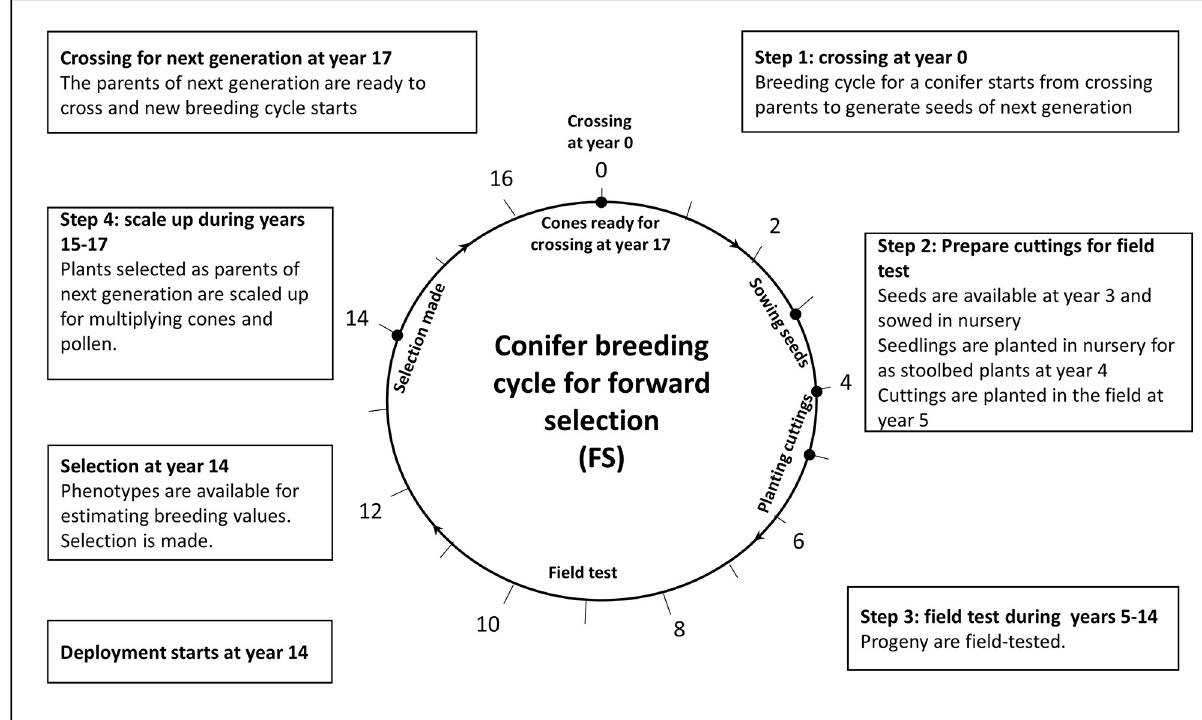
Fig 1. Example of conifer breeding cycle for conventional forward selection with a generation interval of 17 years.